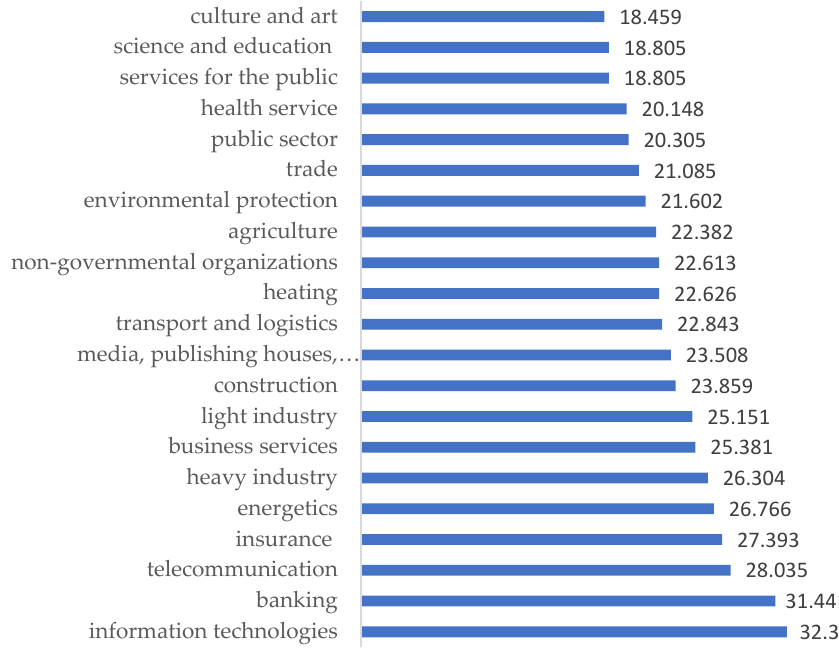
Figure 3. Medians of monthly salaries of individuals employed in selected industries in Poland in 2020 (gross, in EUR). Source: [78]. According to the average currency exchange rates of NBP (National Bank of Poland) of 31.12.2020.